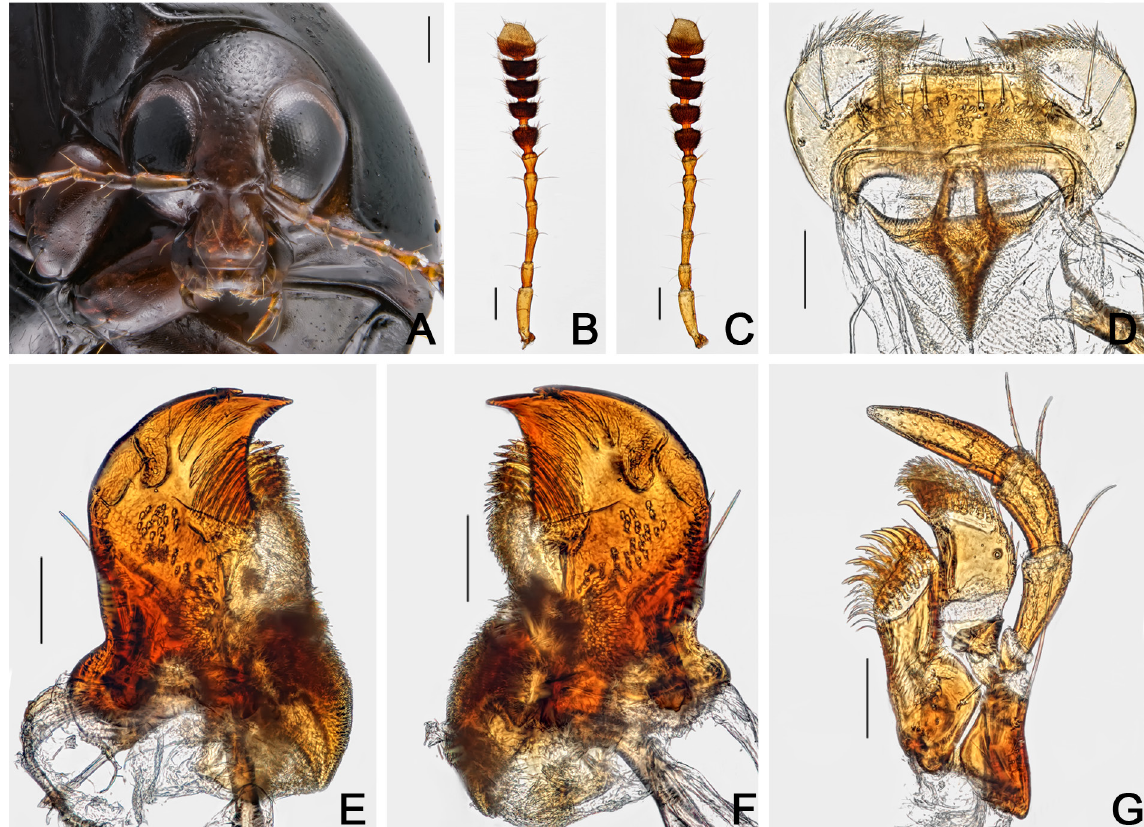
Fig. 57. Cyparium oberthueri Pic, 1956 (CELC). A . Frontal view. B . Male antenna. C . Female antenna. D . Labrum. E . Left mandible. F . Right mandible. G . Maxilla. Specimens collected at Mata da Biologia, Viçosa (MG, Brazil) (CELC). Scale bars: A–C = 0.2 mm; D–G = 0.1